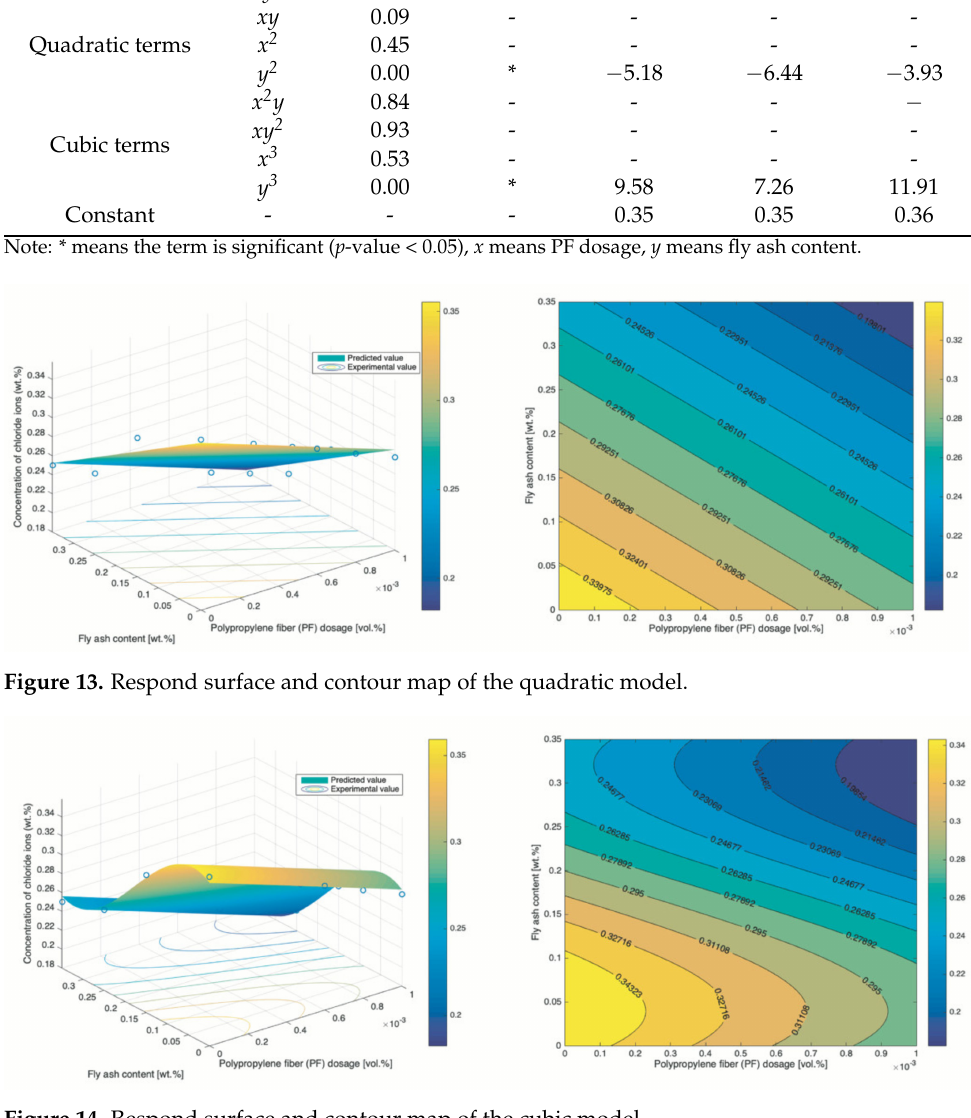
Figure 14. Respond surface and contour map of the cubic